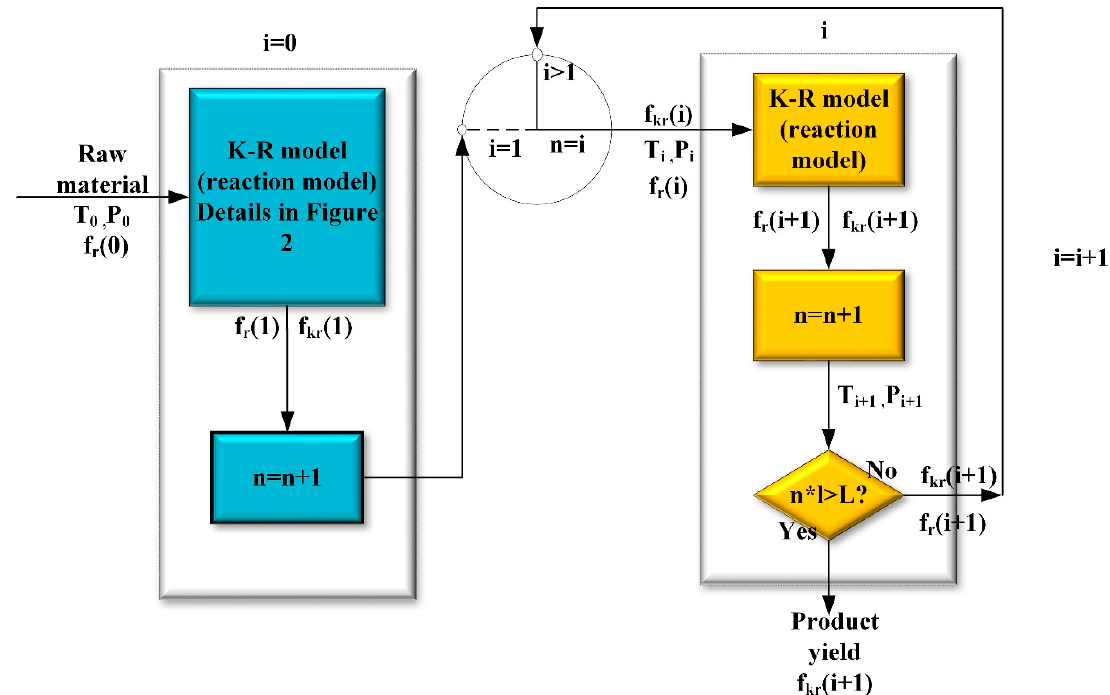
Figure 1. The loop iteration of the K-R model.